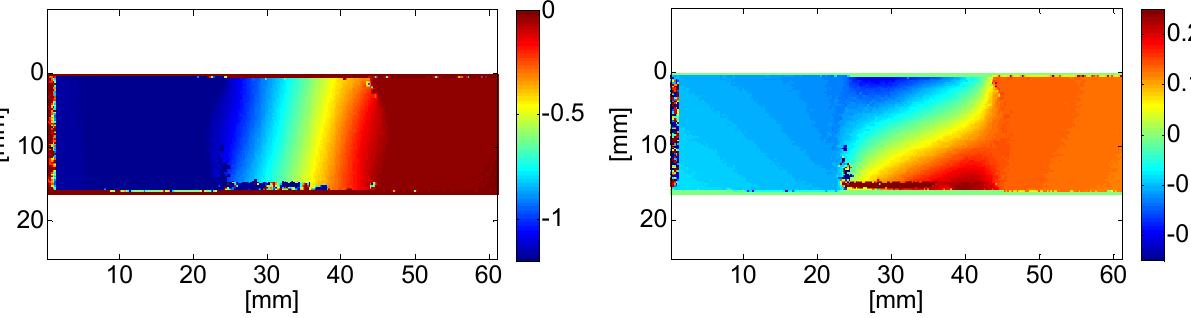
Figure 6: The displacement field in the heterogeneous specimen under tensile test (loaded head on the left, fixed on the right),